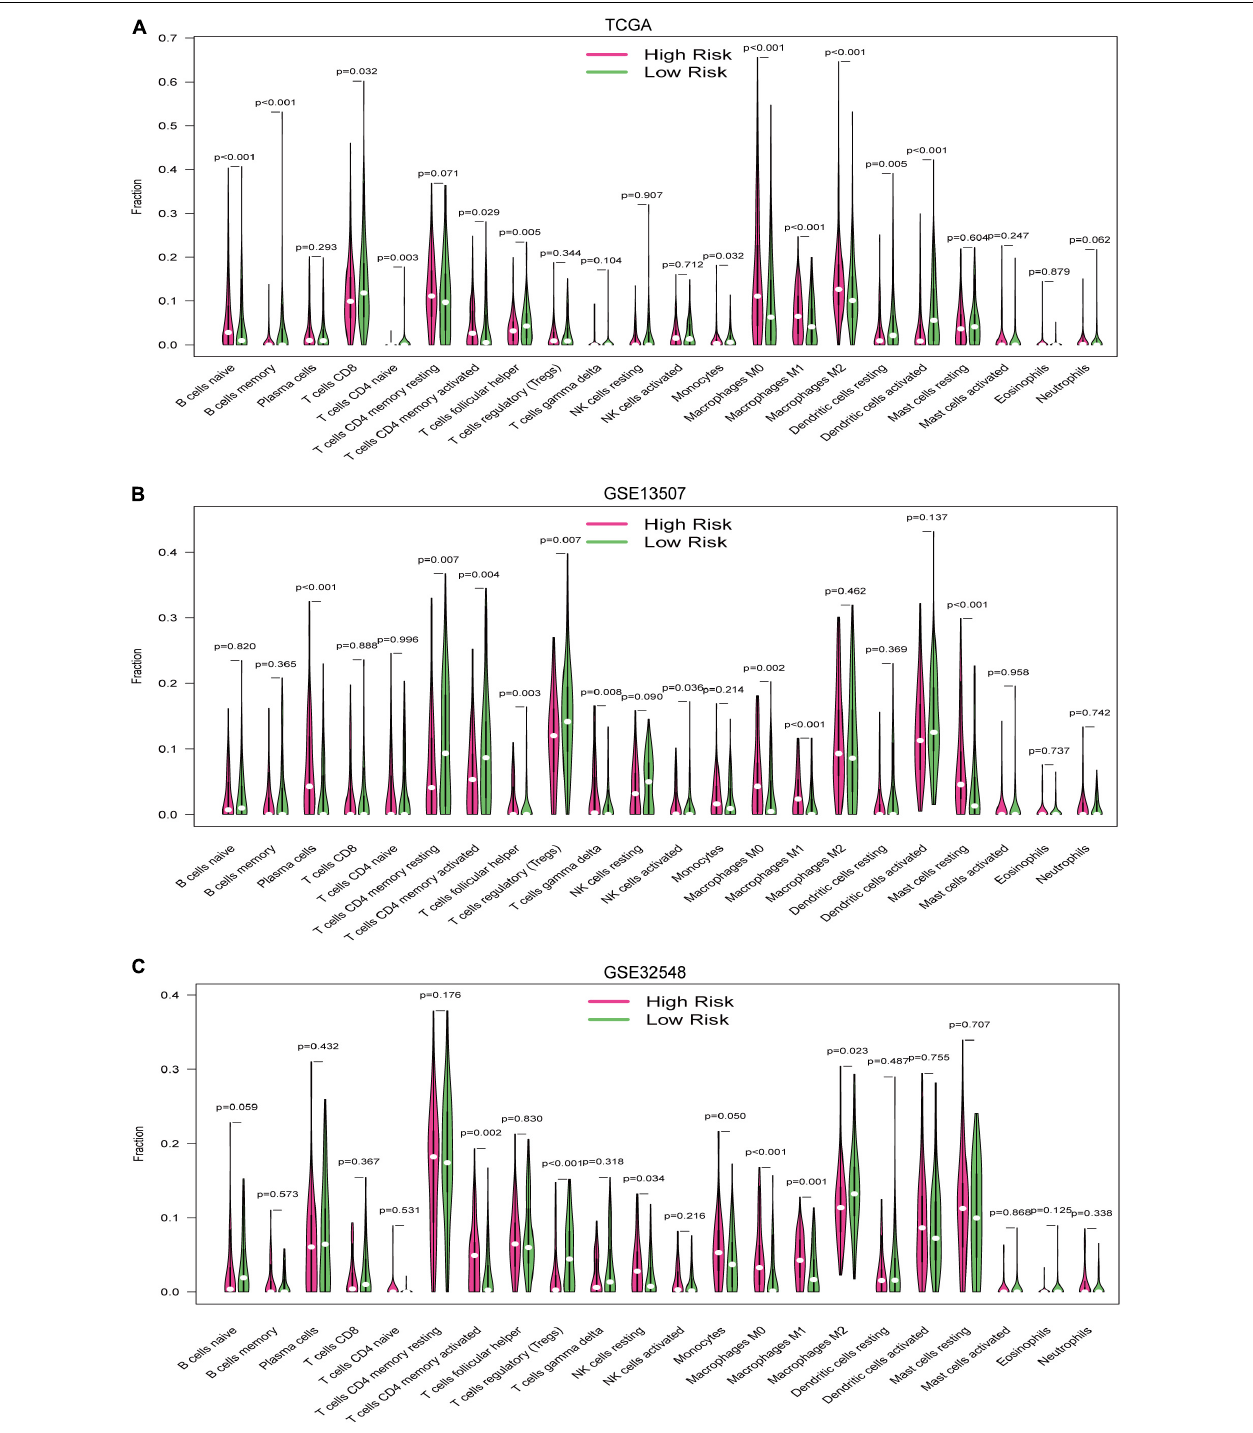
FIGURE 9 | The vioplots of the content of 22 immune cells of the high-risk and low-risk groups in (A) the TCGA dataset, (B) GSE13507, and (C) GSE32548. Activated memory CD4+ T cells and M0 and M1 macrophages were all significantly different in these three datasets. M0 and M1 macrophages had higher infiltration in the high-risk